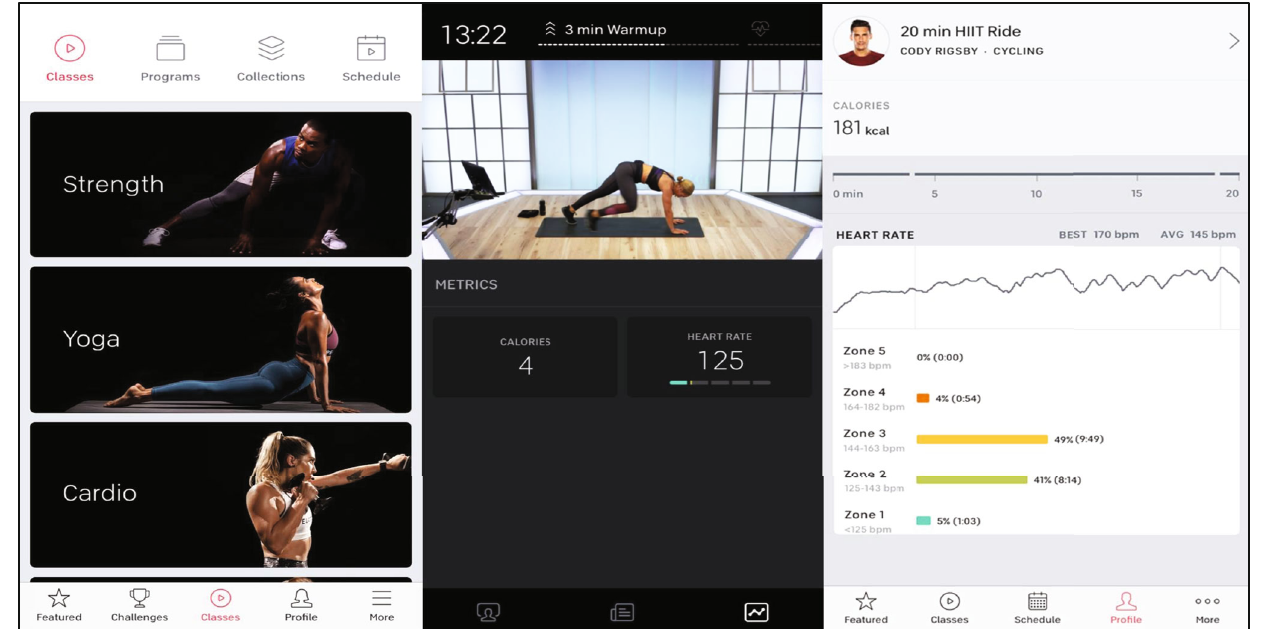
Figure 1: Example of Peloton application user interface.